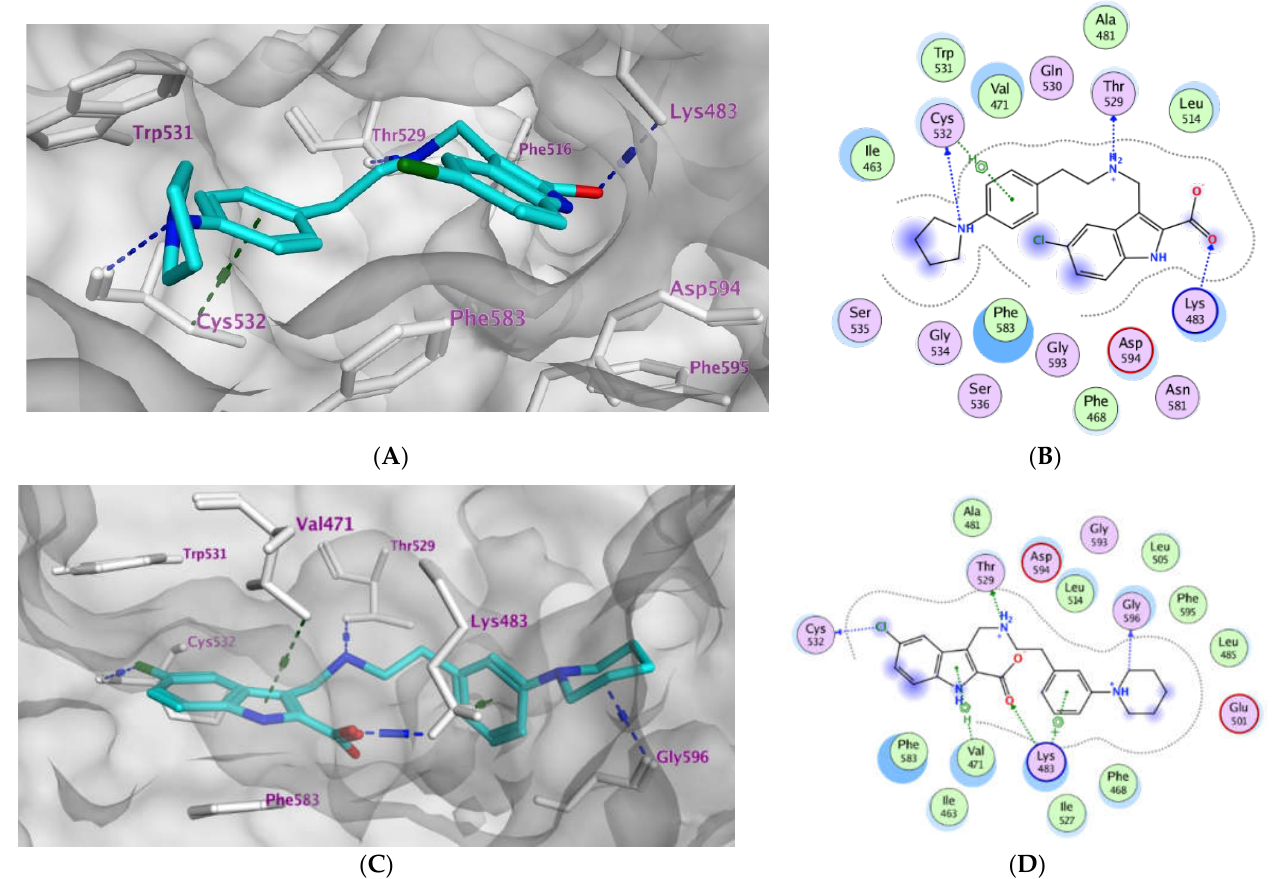
Figure 2. Docking representation models for compounds 3b and 3e ; ( A ): 3D-docked model of compound 3b (cyan) within the active site of BRAF V600E showing the protein surface; ( B ): 2D-docked model of compound 3b within the active site of BRAF V600E ; ( C ): 3D-docked model of compound 3e (cyan) within the active site of BRAF V600E showing the protein surface; ( D ) 2D-docked model of compound 3e within the active site of BRAF V600E . Table 5. Ligand–protein complex interactions of the tested compounds 3b and 3e within the active site of EGFR T790M